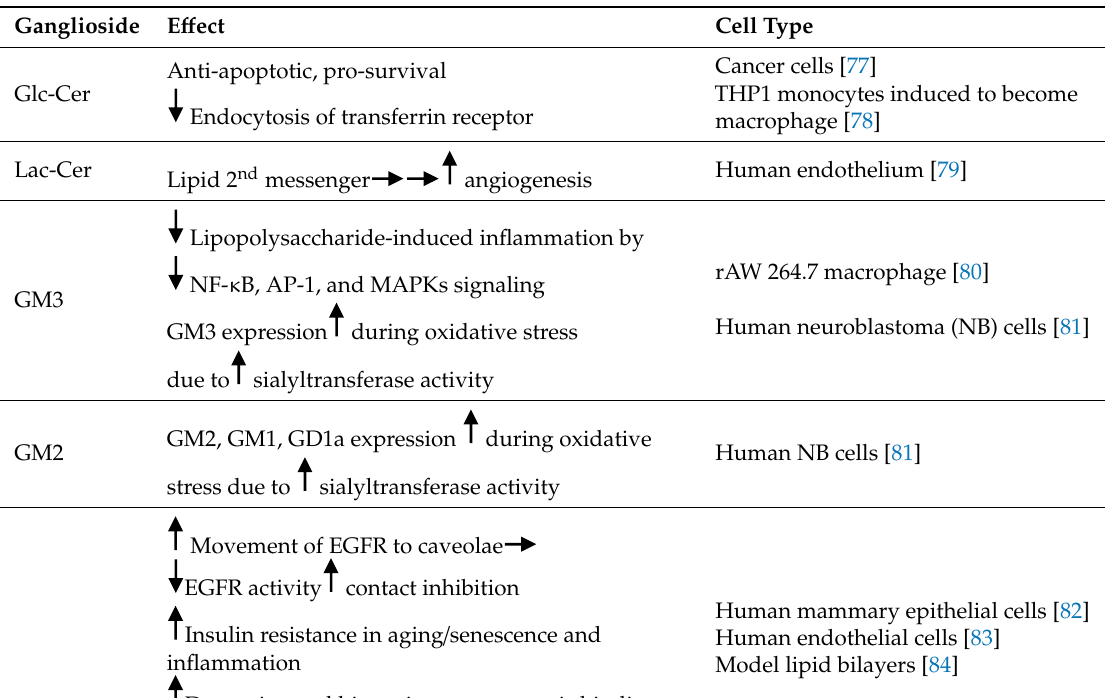
Table 2. Examples of controls of activity of enzymes needed for synthesis of neural gangliosides from ceramide. * Animal sources are indicated as results may be species-dependent. Arrows pointing up indicate an increase, arrows pointing down, a decrease.